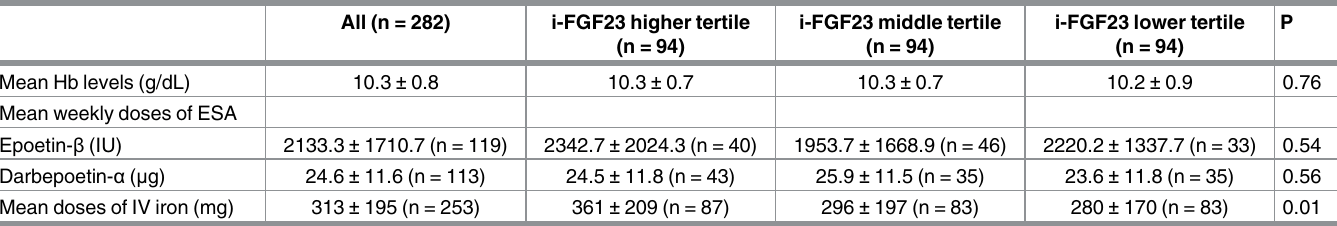
Table 3. Mean doses of erythropoiesis stimulating agent and intravenous iron, and mean hemoglobin levels over 24